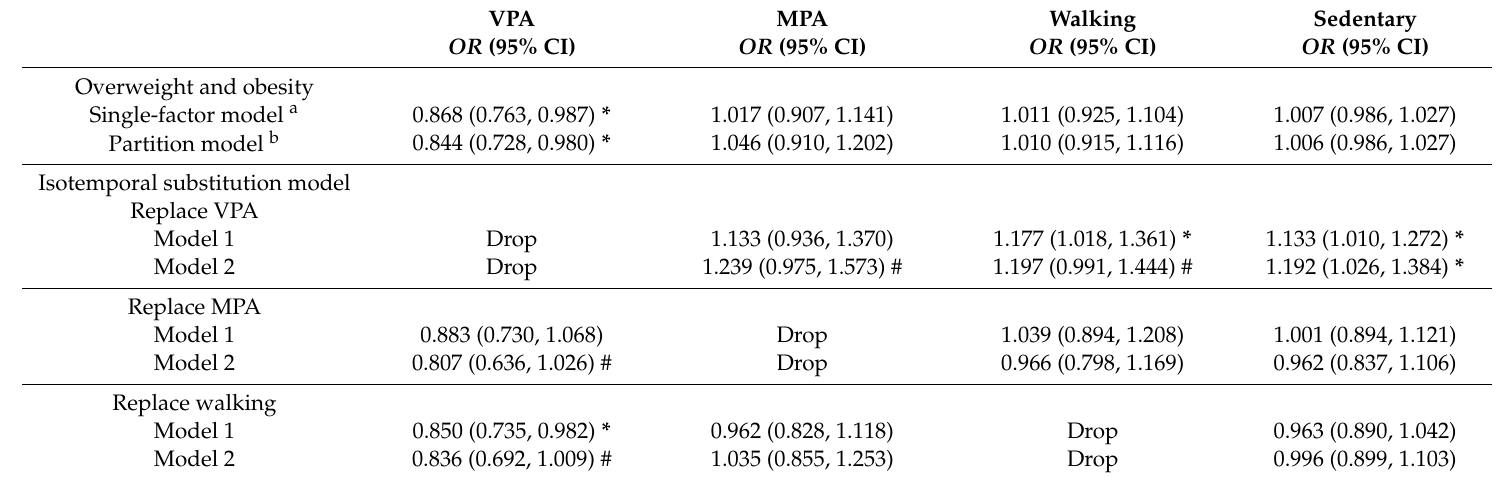
Table 5. Single-factor, partition, and isotemporal substitution models of association between 30 min / d change in di ff erent intensity categories and changes in weight